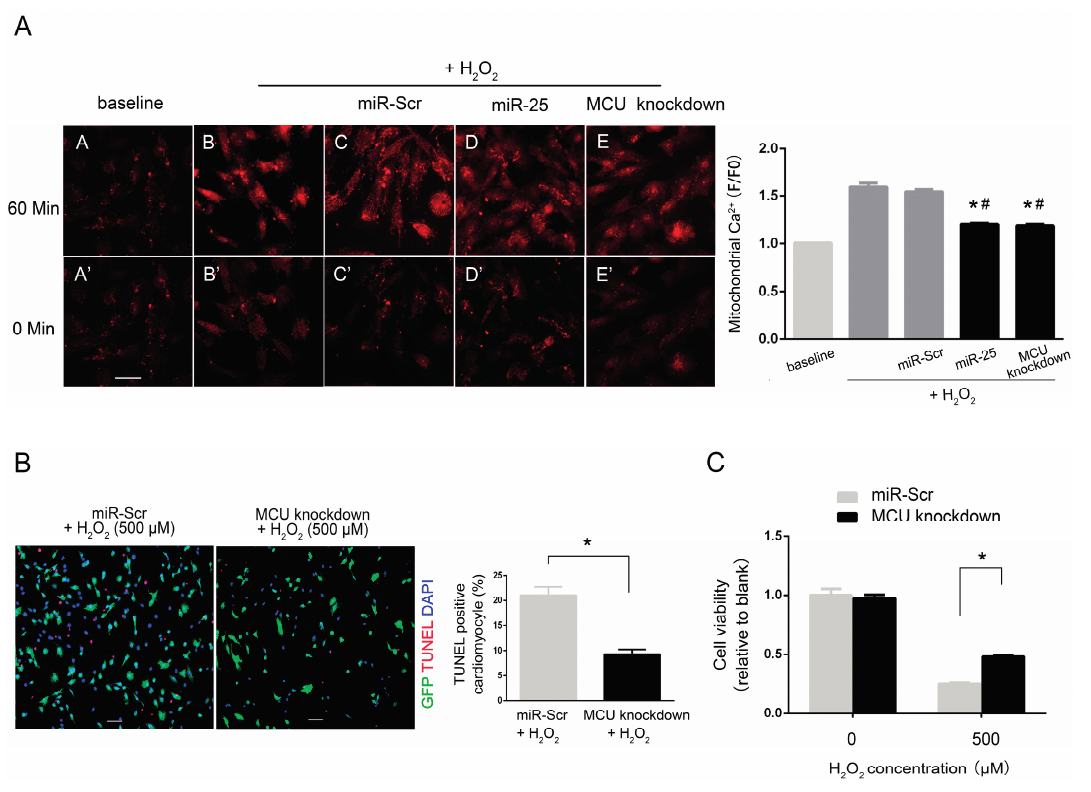
Figure 5. MiR-25 over-expression and MCU knockdown individually blocked H 2 O 2 -induced mitochondrial Ca 2+ elevation in H9c2 cells. Mitochondrial Ca 2+ was determined by Rhod-2 AM, a mitochondrial-specific Ca 2+ probe, after the treatment of 500 μ M H 2 O 2 for 60 min. Cells were infected with a lentivirus carrying the miR-25 precursor (miR-25) or a scramble control sequence (miR-Scr) or MCU shRNA (knockdown). ( A ) Representative images ( left ) and quantitative analysis ( right ) of cells stained with Rhod-2 AM. Scale bar: 50 μ m; ( B ) Representative images ( left ) and quantitative analysis ( right ) of the TUNEL assay. Apoptotic cells were stained red by the TUNEL assay. Scale bar: 100 μ m; ( C ) Cell viability of H9c2 cells stimulated with H 2 O 2 , determined by CCK-8 assay. Data are means ± SD from three independent experiments. * p < 0.05 vs. H 2 O 2 + miR-Scr, # p < 0.05 vs. H 2 O 2